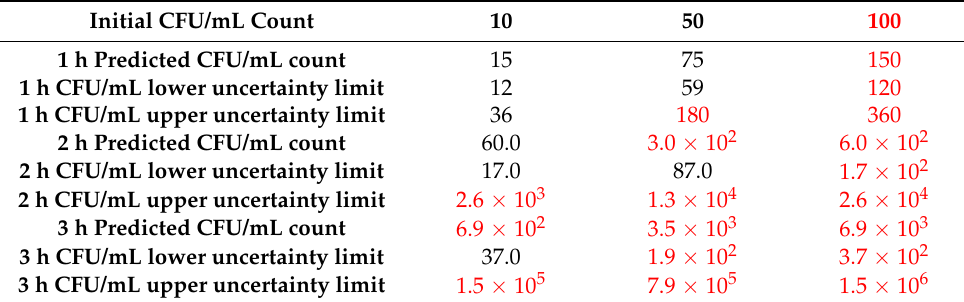
Table 7. Prediction of B. cereus concentrations after 1, 2, and 3 h of storage at +42 ◦ C for initial post-pasteurization concentrations of 10, 50, and 100 CFU/mL. Calculated values and the lower and upper limits of uncertainty are shown.